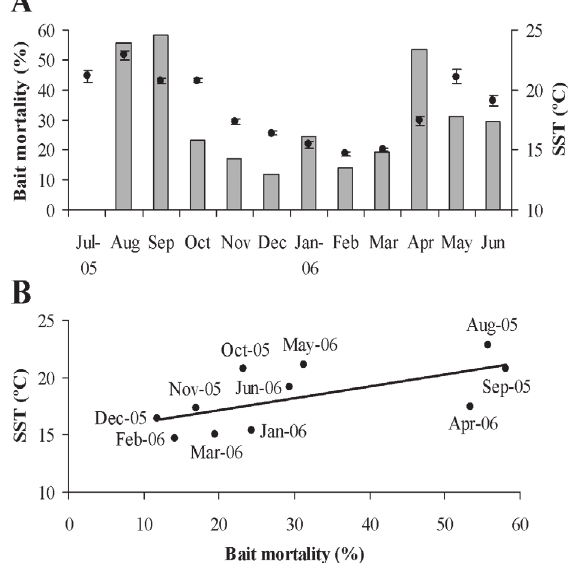
F ig . 4. – relationship between bait mortality (percentage of dead cockles in the “wallet-line” at the end of three fishing days) and the surface seawater temperature (sst) during the experimental fishing surveys: a) Monthly variation during the study period; B) linear regression established between bait mortality and surface seawater